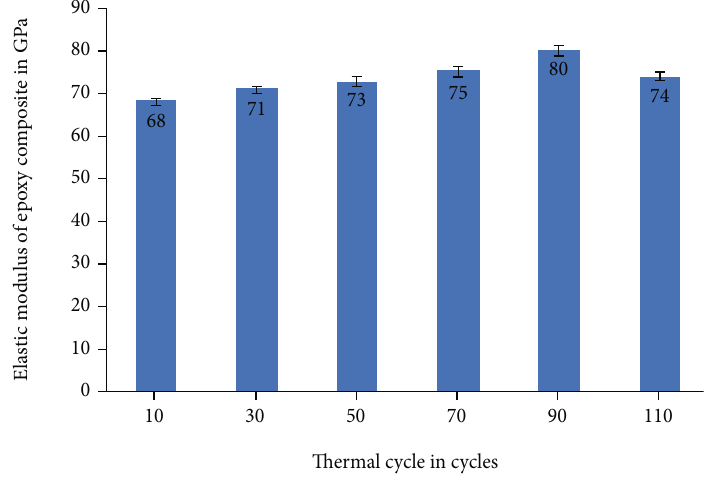
Figure 7: Elastic modulus of epoxy composite with various thermal cycles.